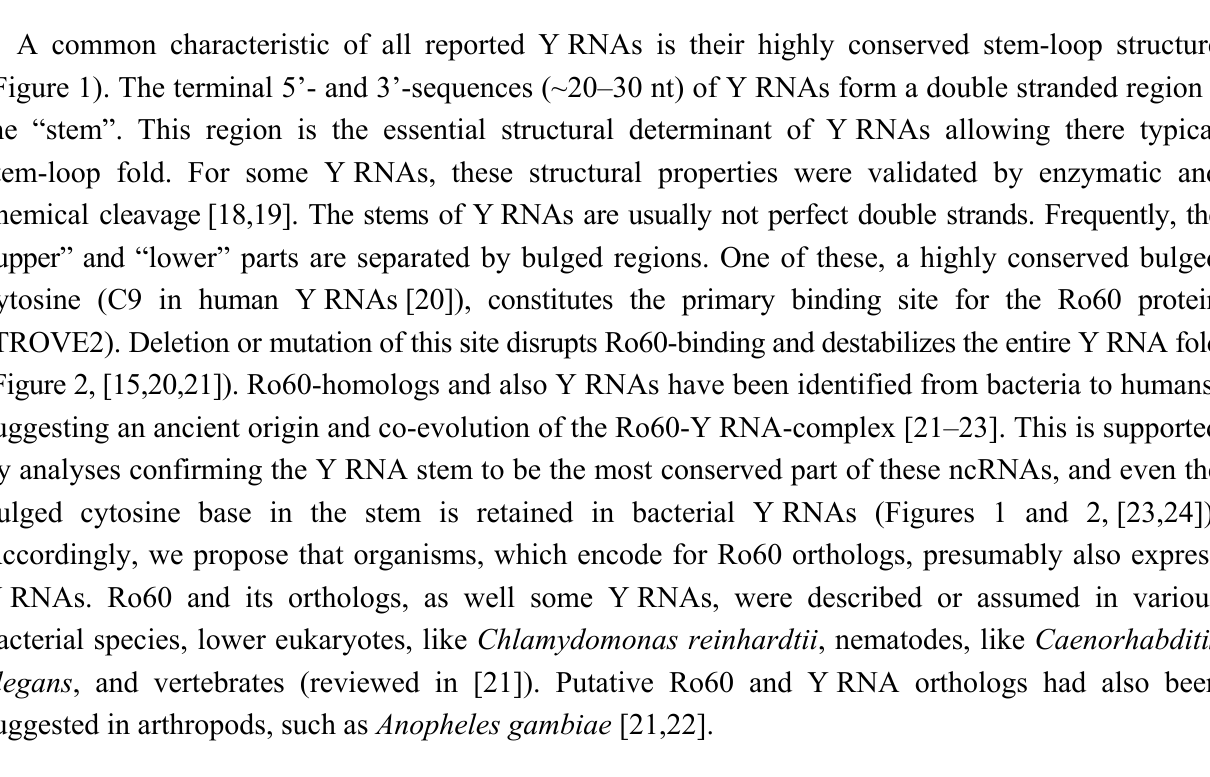
Figure 2. Sequence alignments of human Y RNA stems. The terminal Y RNA stem sequences were aligned using the TCoffee web server [25,26]. Perfectly conserved nucleotides are marked with asterisks. The remarkably conserved cytosine base at position 9 within the 5’-part of the Y RNAs is highlighted in